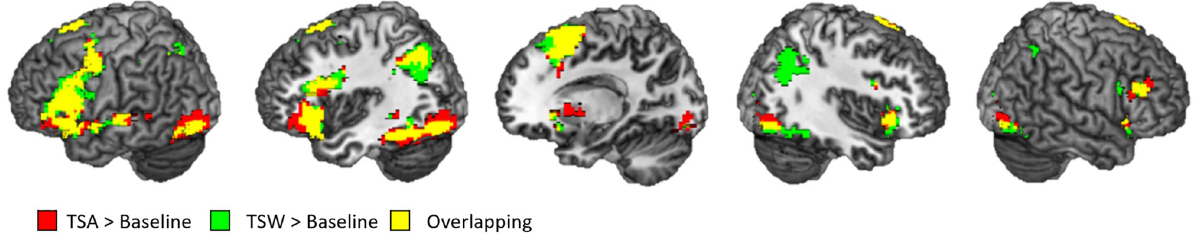
Fig 3. The results of whole brain analysis. Red color indicates TSA > Baseline, green color indicates TSW > Baseline, and yellow color indicates overlapping brain areas. p < .05 FDR-corrected at a cluster level, p < .001, K s > 30 at a voxel level.